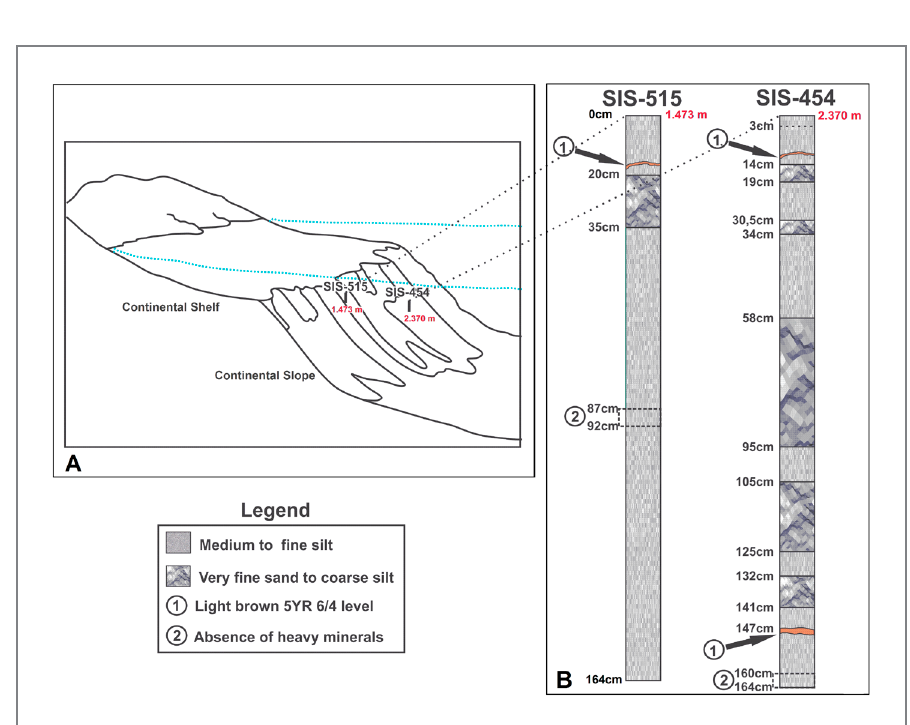
Figure 2 - Schematic stratigraphy of the SIS-515 and SIS-454